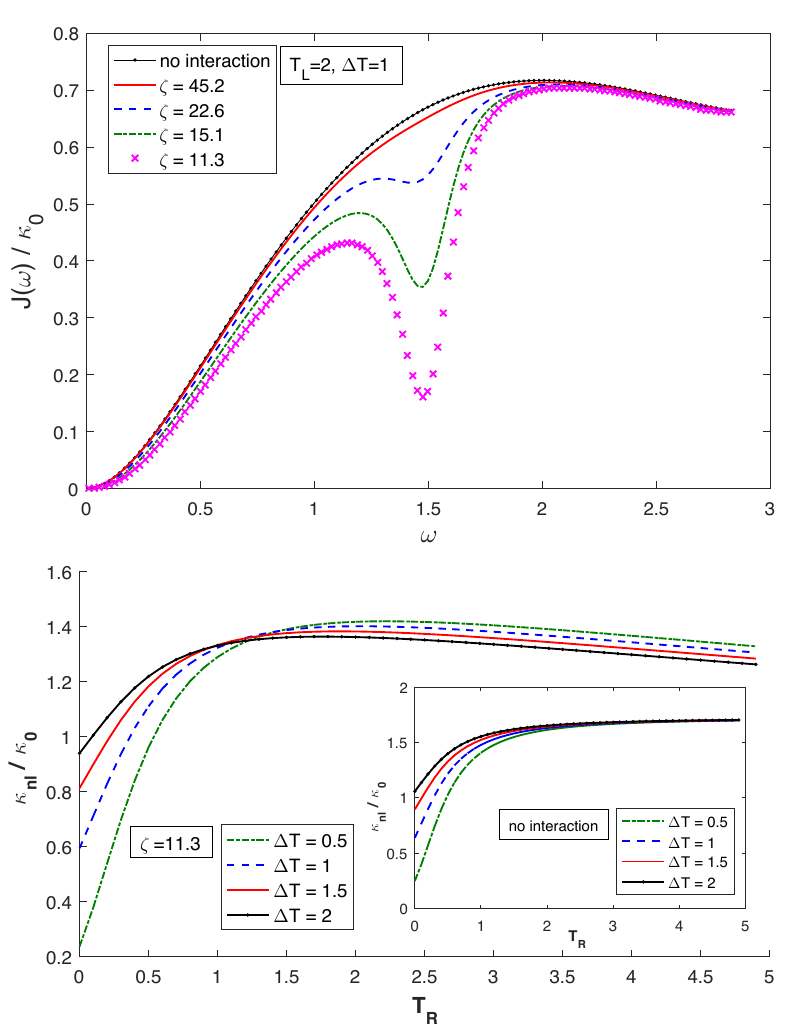
Figure 7. Effect of a single localized phonon on the thermal current as a function of frequency for various surface disorder ( top panel ) and the non-linear thermal conductivity as a function of the temperature T R of the cold lead for various temperature differences ( bottom panel ). Frequency and temperature are given in units introduced in the text. Reprinted from Ref.